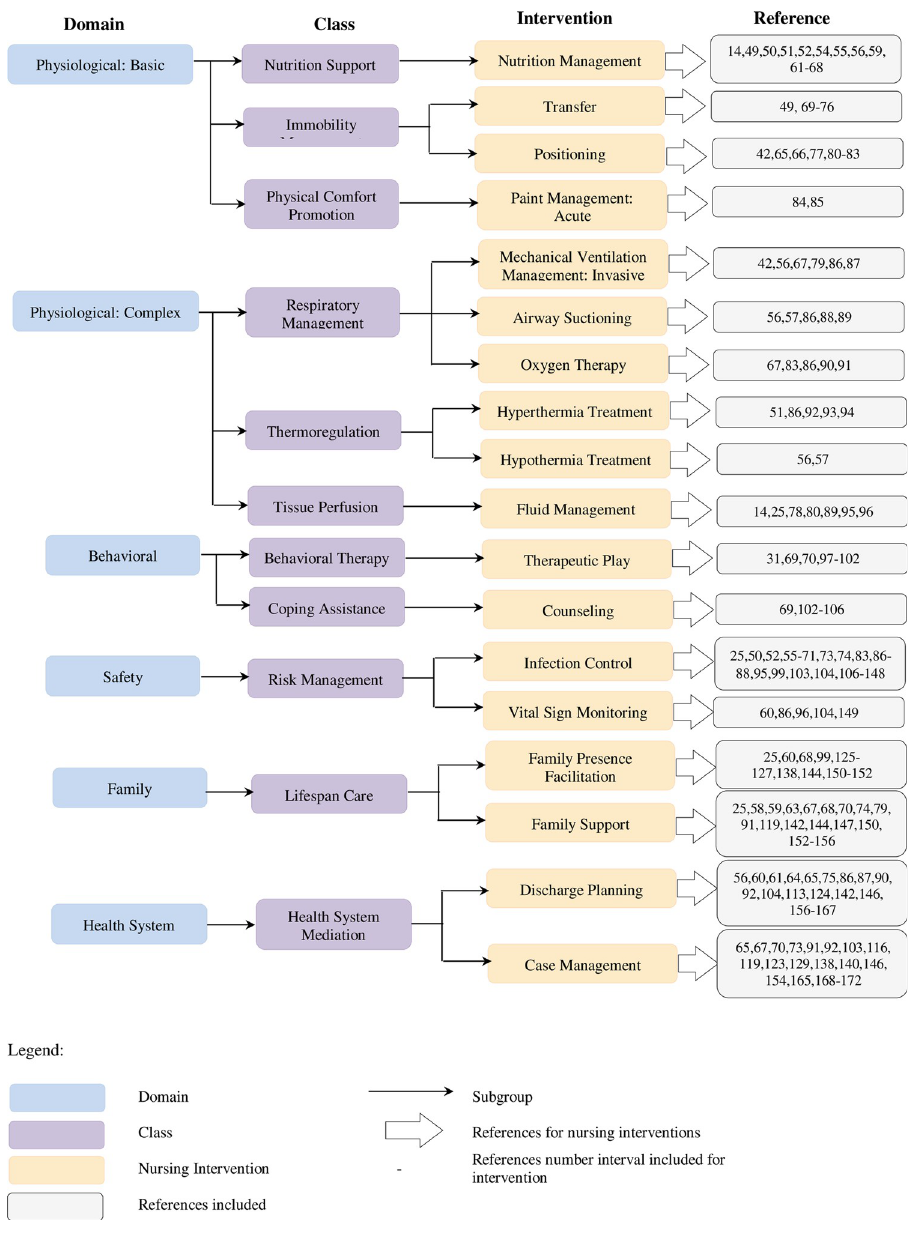
Fig 2. NIC framework for including